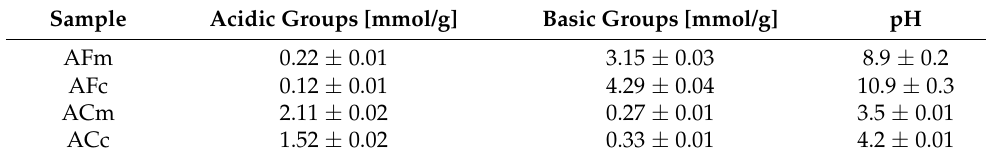
Table 3. Acid-base properties of the biocarbons obtained.